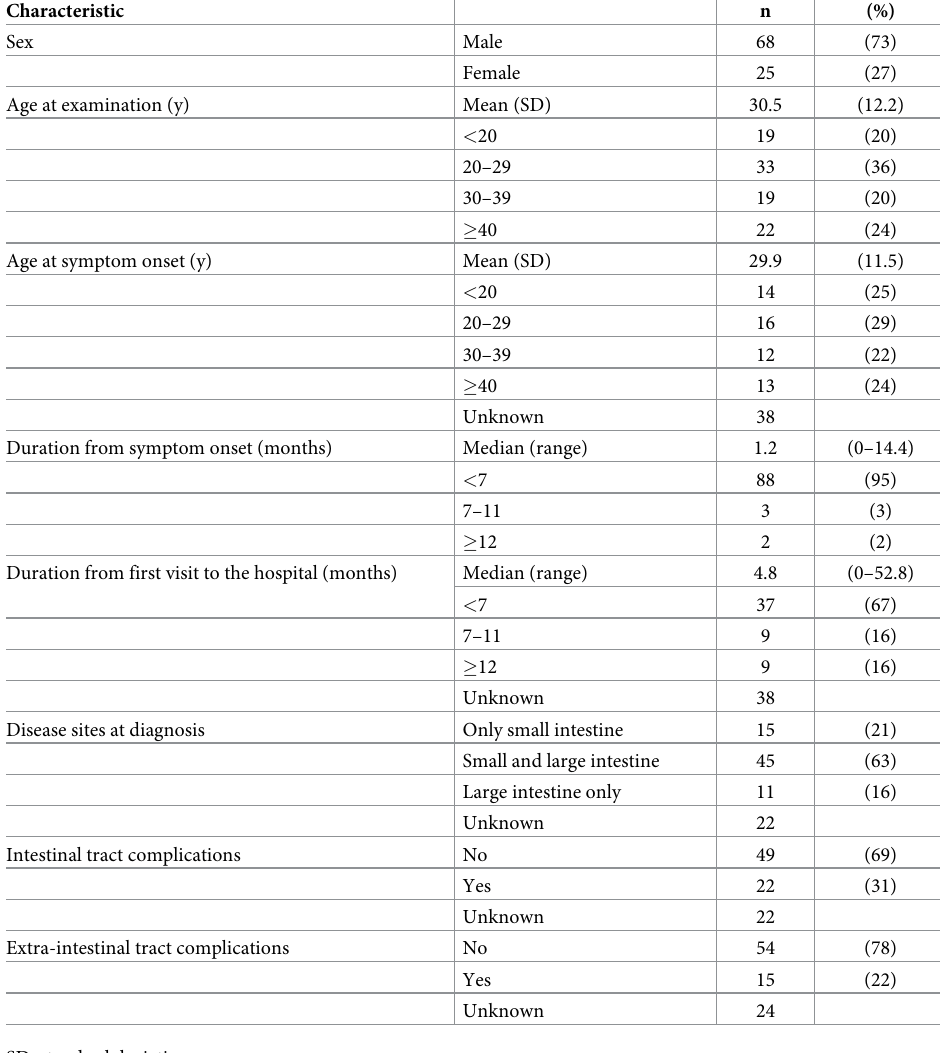
SD, standard deviation � Data expressed as n (%) unless otherwise